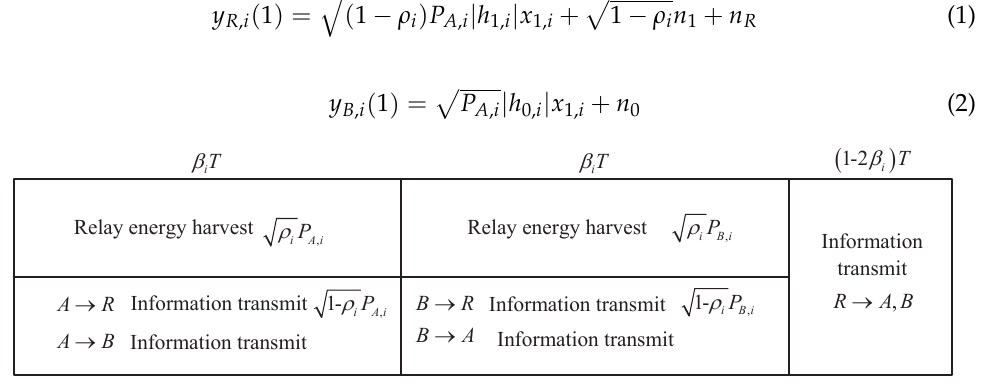
Figure 2. Structure of two-way energy-carrying relay communication system under TDBC